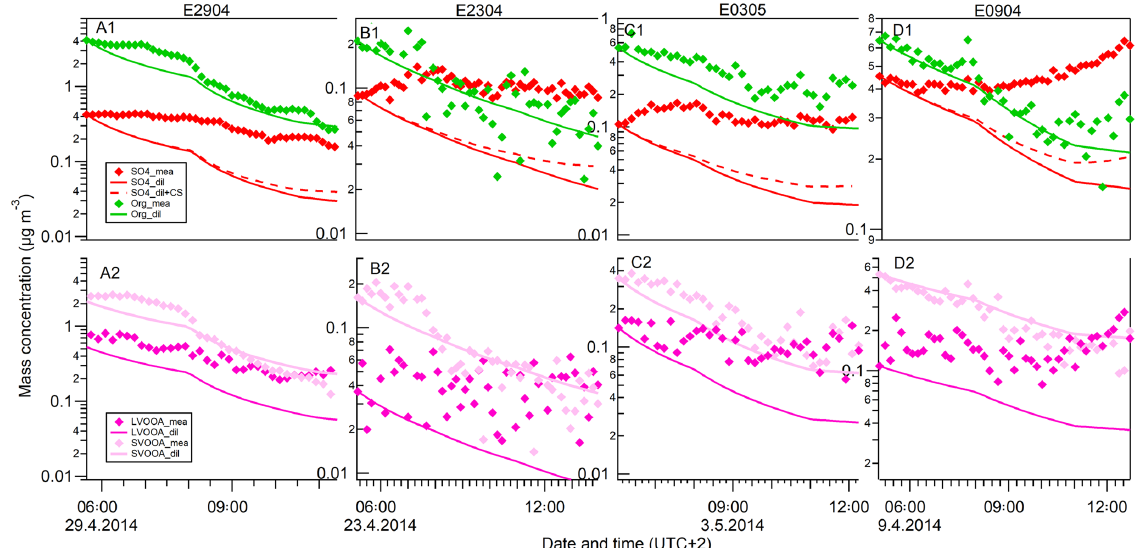
Figure 4. The time series of sulfate and organics (a1–d1) , and LVOOA and SVOOA (a2–d2) aerosols depending on the dilution and vapor condensation effects before nucleation events in four events (orange bars in Fig. 2). Diamond markers: the measured aerosol concentrations. Solid lines: the modeled aerosol concentrations assuming PBL heights to be the only controlling factor on aerosol mass concentrations. The aerosol concentrations were calculated by accounting for the air volume varying with PBL height. Dashed lines: the modeled aerosol concentrations accounted for by both the dilution effect and condensation of sulfuric